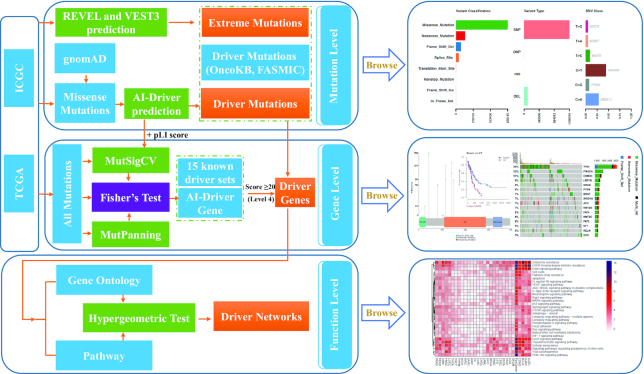
Workflow of OncoVar pipeline. The somatic missense mutations identified from TCGA and ICGC cohorts were used for driver mutation prediction with our recently developed AI-Driver method. Somatic missense mutations with AI-Driver score ≥0.95 and occurred in at least two patients were defined as driver mutations. The MutsigCV, with two additional gene-level covariates – pLI score and maximum AI-Driver score, and MutPanning methods were used for ranking the genes based on the generated P values with all somatic mutations identified from TCGA and ICGC cohorts, respectively. Then, two P values were combined by using Fisher method for each gene and further corrected by Benjamini–Hochberg method. Genes with a corrected P value ≤0.05 were considered as AI-DriverGenes. AI-DriverGenes combined with other 15 known driver sets were used for gene classification and the pathogenic genes with score ≥20 (Level 4) were considered as driver genes. Only the driver genes with driver or extreme mutations were used for gene-level exploration. Finally, driver genes were used to identify driver pathways (FDR < 0.05) by using the hypergeometric test.